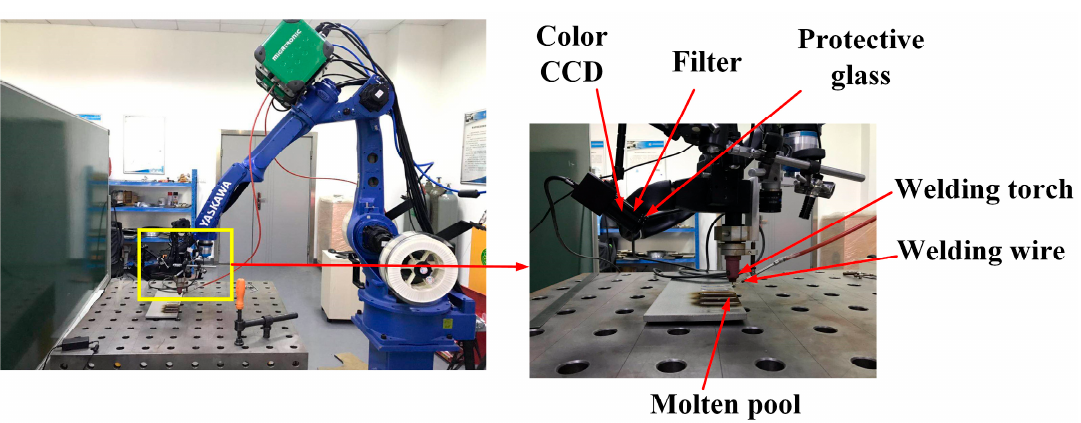
Figure 2. Diagram of molten pool visual sensing system device.